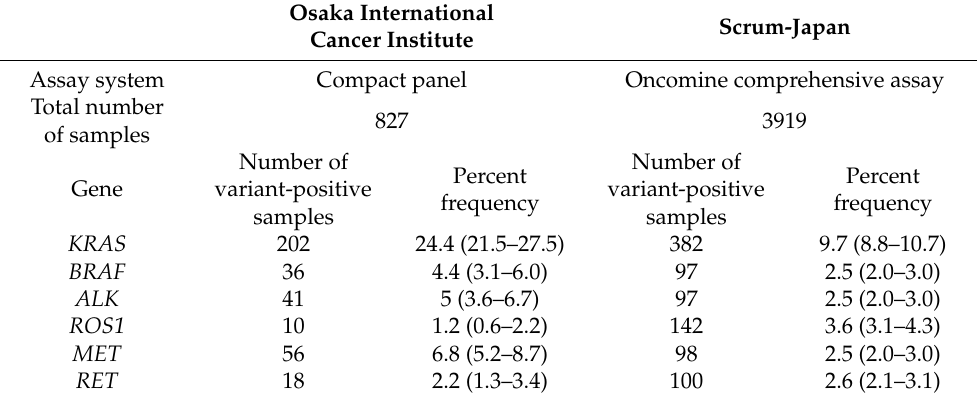
Table 5. Frequencies of mutations and fusions among EGFR mutation-negative samples. Parentheses in percent frequency indicate the 95% confidence interval. Samples from the Osaka International Cancer Institute were obtained from 3 February 2011 to 24 August 2020. The number of BRAF V600E and KRAS G12C samples was 11 and 77, respectively. Osaka International Scrum-Japan Cancer Institute Assay system Compact panel Oncomine comprehensive assay Total number 827 3919 of samples Number Number of Percent Gene variant-positive frequency samples